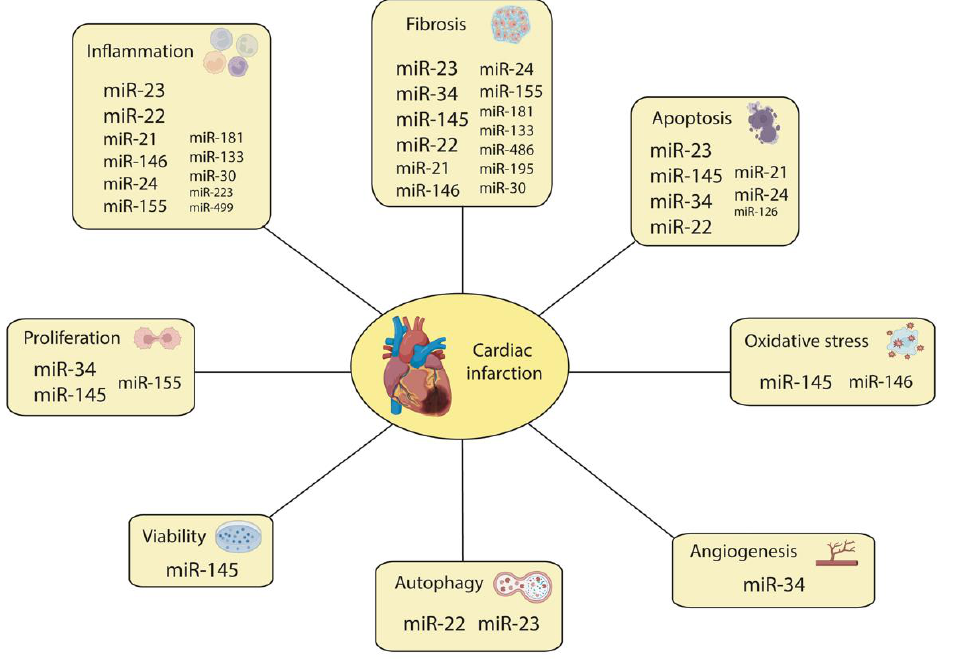
Figure 3. Schematic representation of the distinct miRNAs reported to be involved in distinct biological processes during MI. microRNAs are depicted in large, intermediate, and small sizes according to the number of biological events in which they are involved, e.g., miR-23 is larger since it is involved in inflammation, fibrosis, apoptosis, and autophagy, while miR-30 is only involved in fibrosis. Note that there is increasing information available about the role of microRNAs in three critical biological processes involved in MI, i.e., inflammation, fibrosis, and apoptosis, while the information on their roles in other biological processes, such as proliferation, cell viability, autophagy, angiogenesis, and oxidative stress, is still incipient.